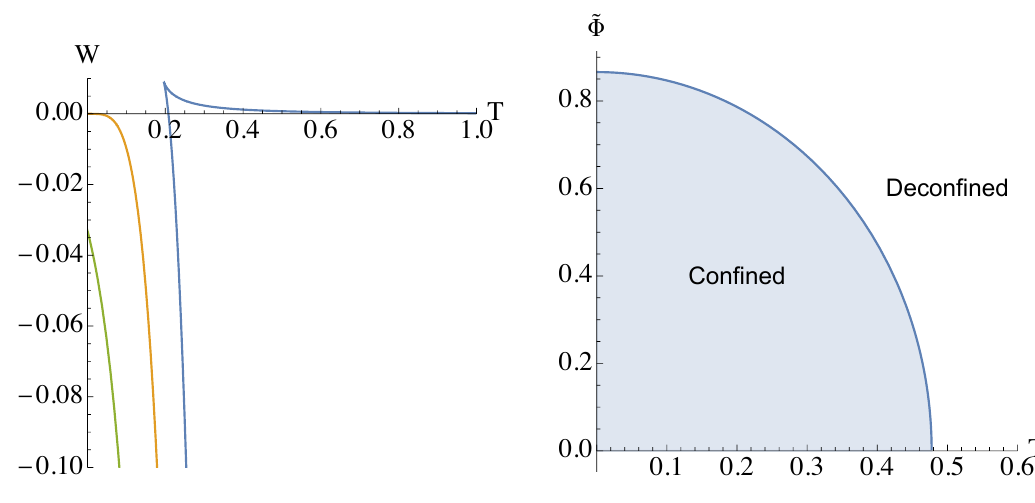
(˜Φ Figure 2 . Free energy W vs. temperature T plot and phase diagram for the fixed , V , C ) ensemble √ in d = 4 . Left : W − T plot for the parameters R = 1 , C = 1 and ˜Φ = 0 . 9Φ (blue), ˜Φ = Φ = 3 / 2 c c (orange) and ˜Φ = 1 . 1Φ (green). For ˜Φ < Φ the free energy curve consists of two branches ending in c c a cusp, the upper branch corresponds to a low-entropy state and the lower branch to a high-entropy state. At W = 0 there is a first-order phase transition between the high-entropy “deconfined” state and a “confined” state, dual to a generalised Hawking-Page transition between a large black hole and thermal AdS, which depends on the value of ˜Φ here. For Φ ≥ Φ the curve lies below or at the c ˜Φ W = 0 axis and no phase transition takes place. Right : The − T phase diagram for R = C = 1 with a coexistence curve representing a line of (de)confinement phase transitions in the CFT. At ˜Φ = 0 the transition occurs at the Hawking-Page temperature T = T c = 3 / 2 π , and at T = 0 it happens at ˜Φ = ˜Φ c